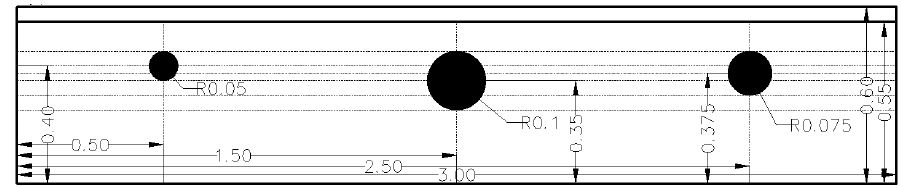
Figure 4. Schematic diagram of a subsurface SWB model. Unit: Meters.